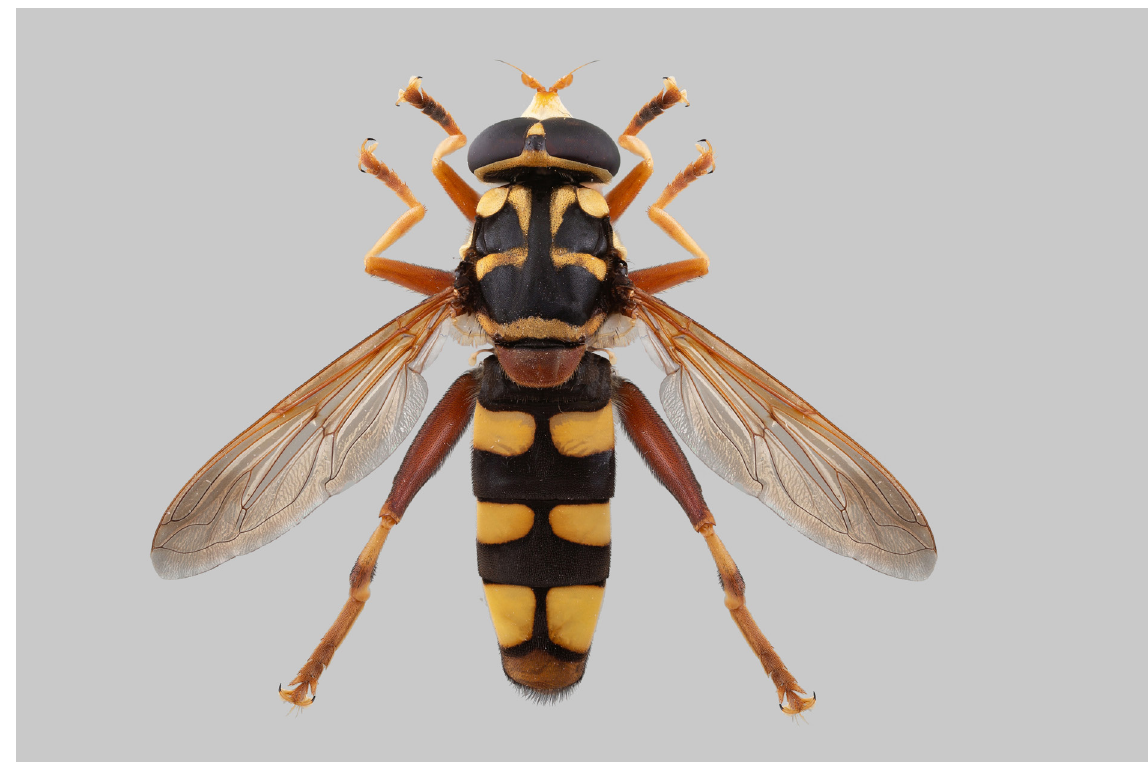
Fig. 5. Milesia semiluctifera (Villers, 1798), ♂, (SBH), habitus dorsal. Collected in Greece, Lesbos, 14 September 2019, leg. and coll. S.